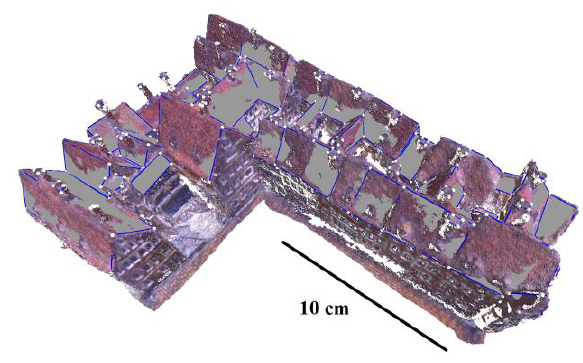
Figure 9. Manual drawing of the polygons representing roof pans and top of chimneys used for the automatic parametric modelling